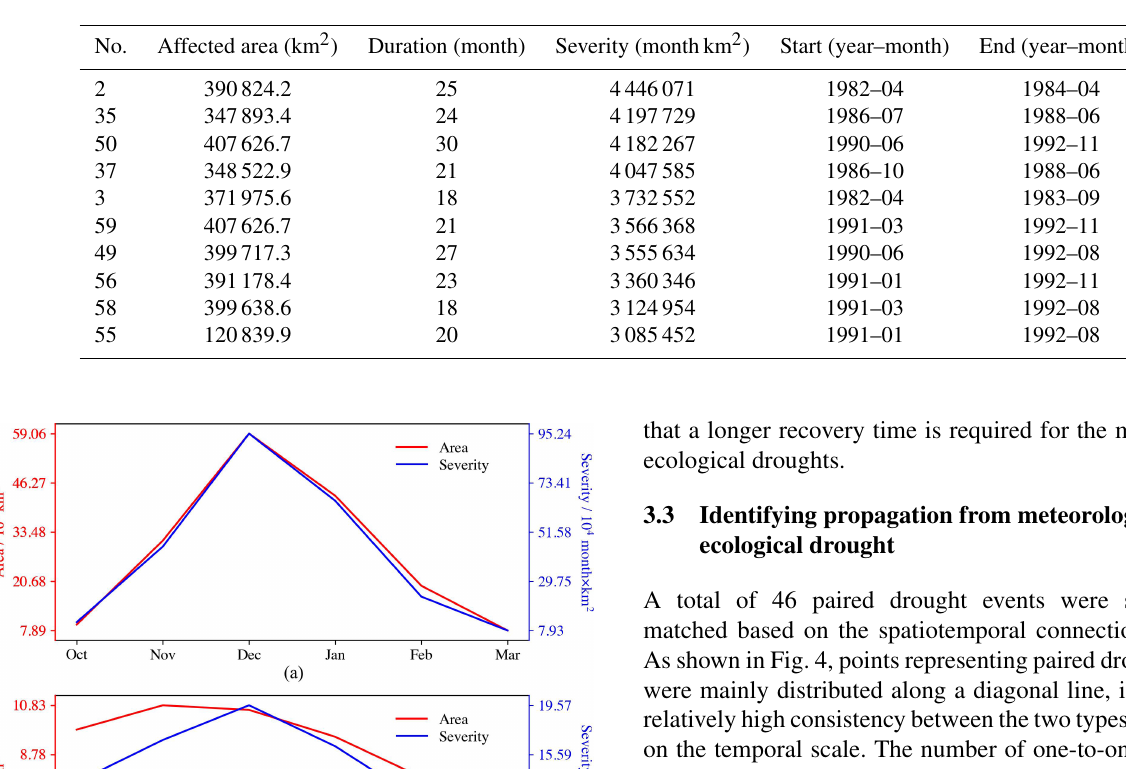
Table 3. Top 10 ecological drought events according to the severity.